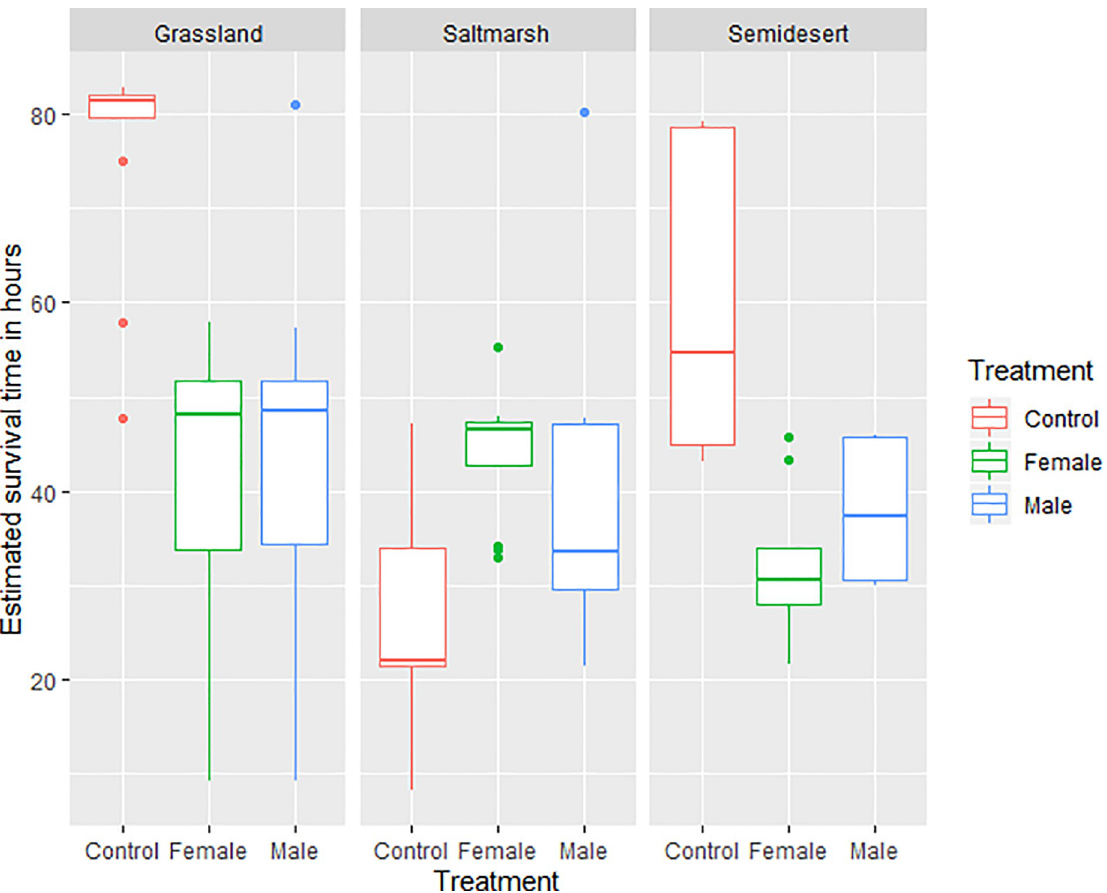
Fig 1. Box plots showing estimated nest survival in relation to habitat and treatment. Total number of nests: N = 107.